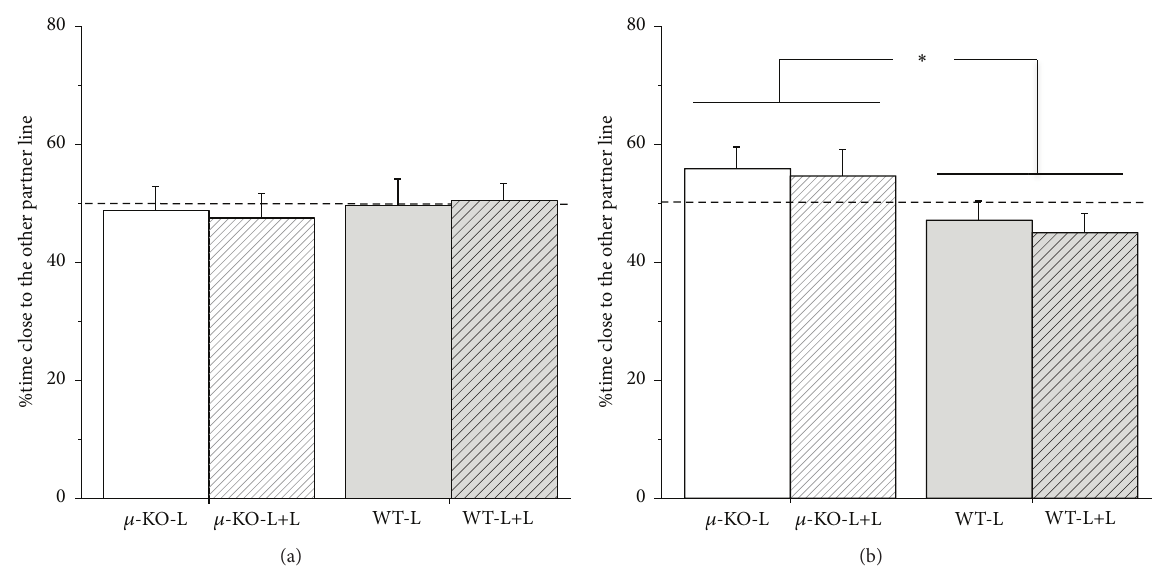
Figure 5: Mean (+SEM) percentage of time spent by adult females (a) and males (b) close to a same sex partner of the other homozygous line in a modified version of the Approach-Avoidance Test, where a 𝜇 -KO and a WT partner mouse were simultaneously presented to the experimental subject. The dotted line represents chance level (50%). 𝑁 : 12–16 per group. 𝜇 -KO-L: Oprm1 −/− pups reared by their mother [16 males + 16 females]; 𝜇 -KO-L+L: Oprm1 −/− pups reared by their mother plus a second lactating female [15 males + 15 females]; WT-L: Oprm1 +/+ pups reared by their mother [16 males + 13 females]; WT-L+L: Oprm1 +/+ pups reared by their mother plus a second lactating female [15 males + 12 females]. Difference due to genotype ∗ 𝑝 < 0.05